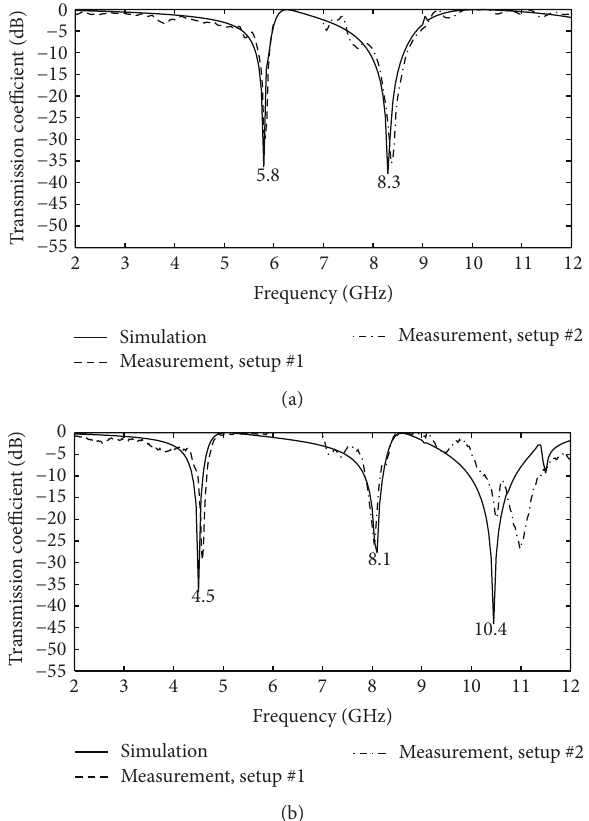
Figure 6: Simulated and measured transmission coefficient results versus frequency for the fabricated FSS prototypes integrating dissimilar Sierpinski fractal patch elements of levels: (a) 𝑘 = 1 and 𝑘 = 2 and (b) 𝑘 = 1 and 𝑘 = 3